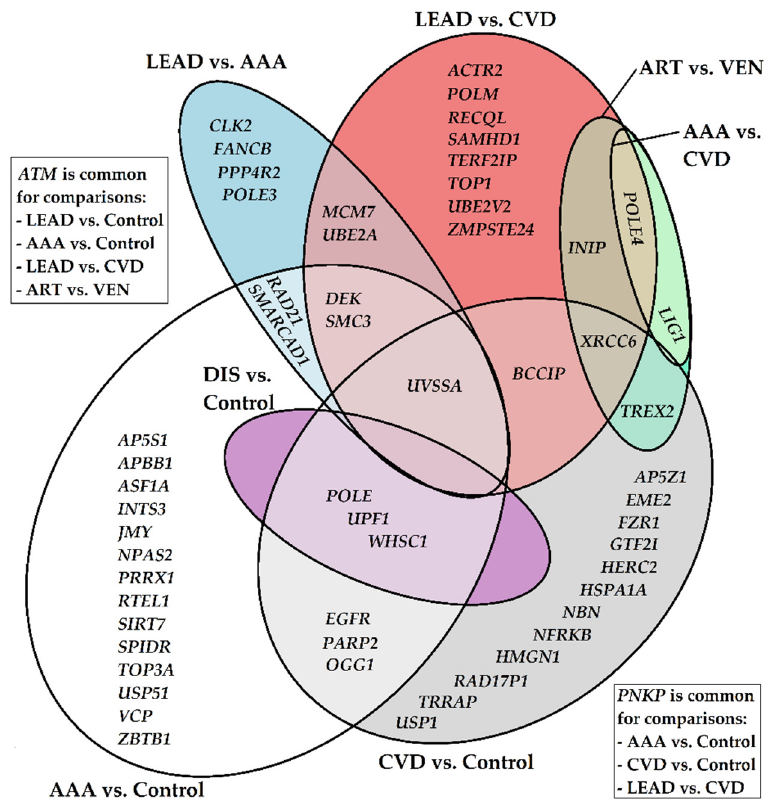
Figure 3. Graphical representation of unique and common genes for gene sets selected from performed comparisons. AAA—abdominal aortic aneurysm, CVD—chronic venous disease, LEAD—lower extremity arterial disease, DIS—pooled group including AAA, CVD and LEAD patients, ART—pooled group of patients with diseases affecting arteries (AAA and LEAD), VEN—patients with disease affecting veins (CVD). Empty fields represent lack of common genes in given comparison(s).